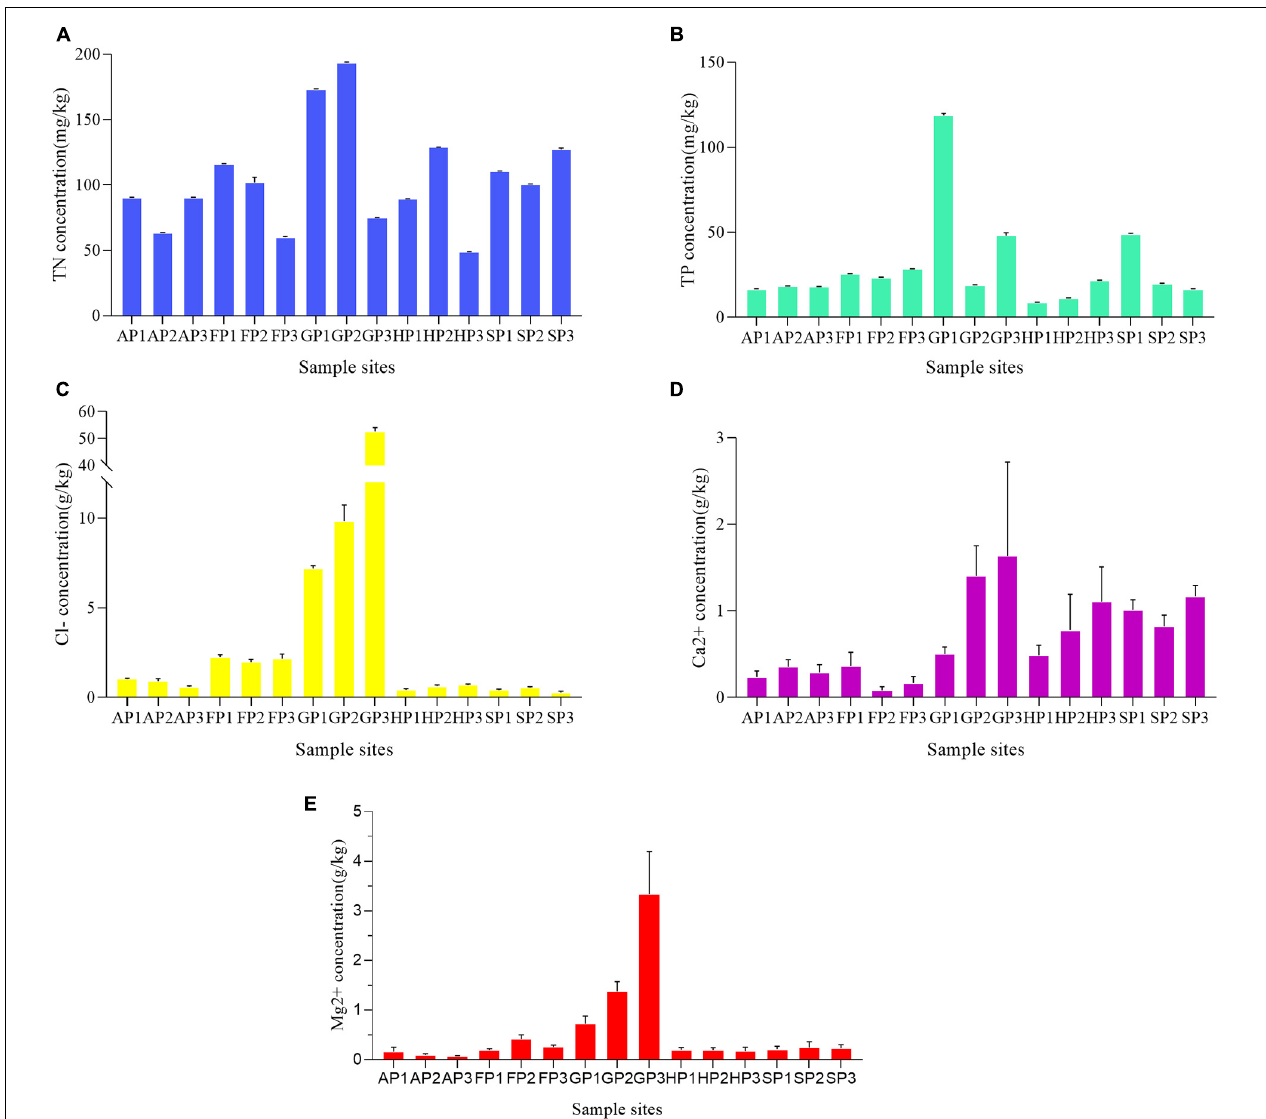
FIGURE 1 | The TN, TP, Cl - , Ca 2 + , and Mg 2 + concentrations (A–E) in the 15 sediment samples.